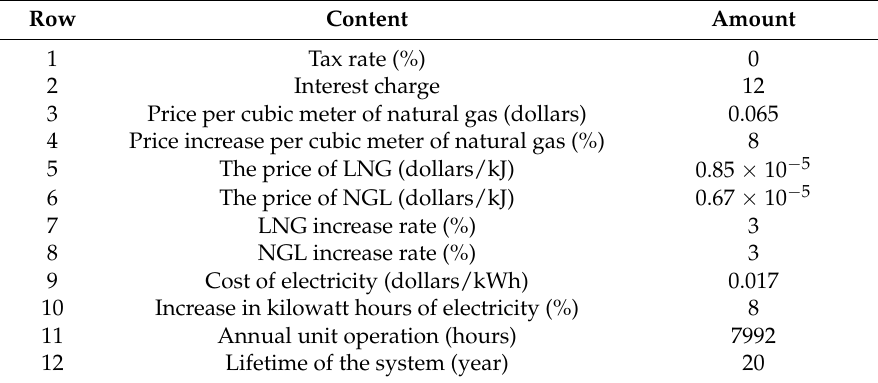
Table 7. Assumptions considered in the economic analysis [30].